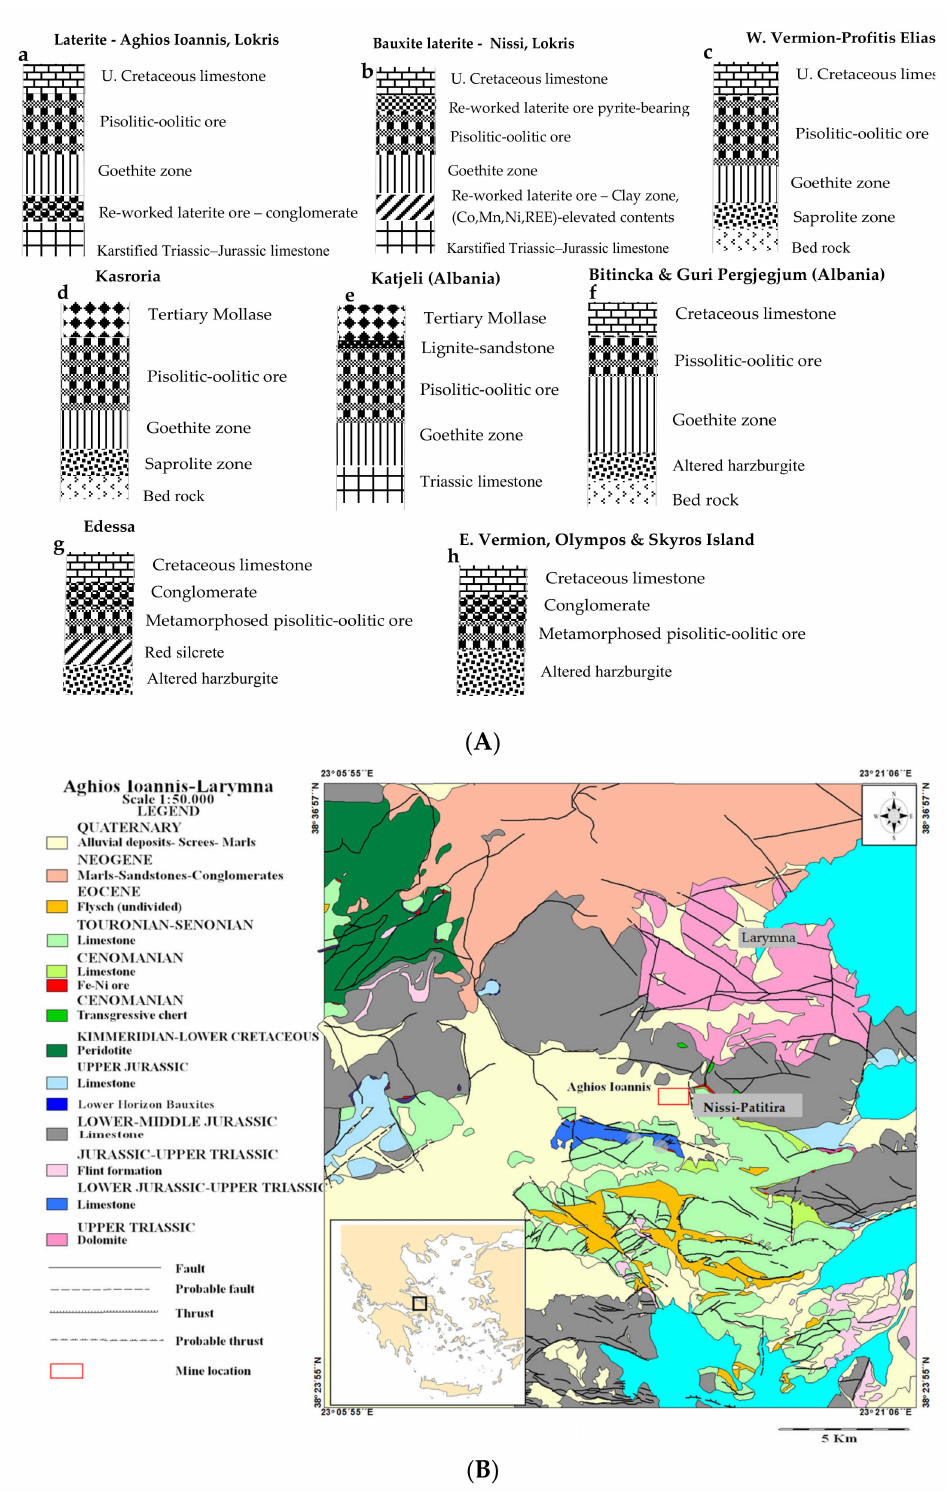
Figure 2. ( A ) Schematic stratigraphic sections of the most representative laterite deposits in the Balkan Peninsula. ( B ) Sim- plified geological map, after LARCO GMM (General Mining and metallurgical Company), cited in ProMine Project [27] showing the location of the main Fe–Ni laterite deposits at Lokris (Aghios Ioannis). Small (1 m × 15 m) lens-like Fe–Ni occurrences, metamorphosed to amphibolite facies (probably erosional remnants of redeposited laterites), are found in the E. Vermion, Edessa, Olympos, and Skyros islands of Greece (Figures 1 and 2A) and are overlain